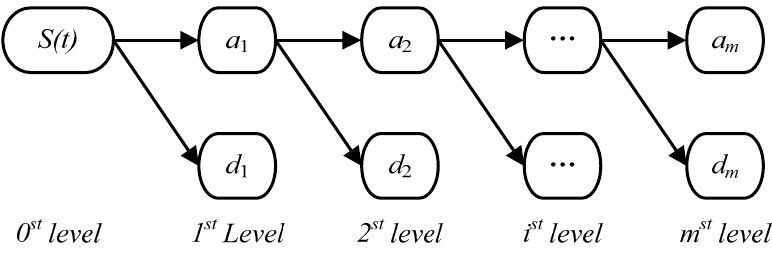
( ) S t . Figure 1. The process of m -level decomposition by WT for time series S ( t )